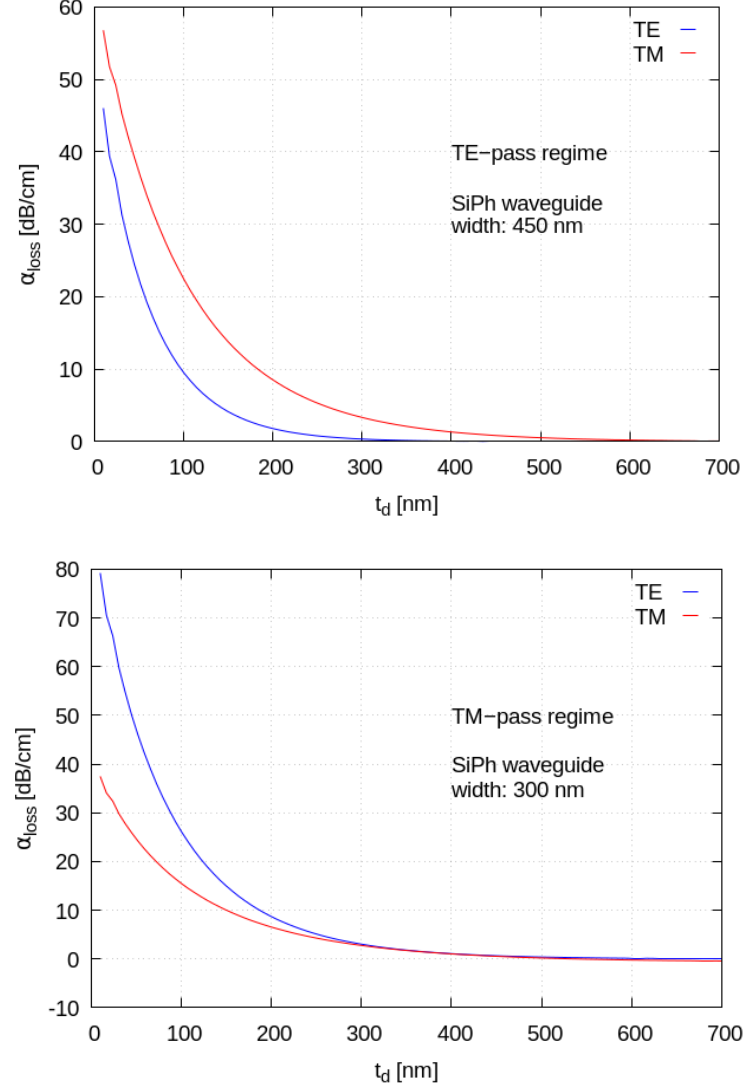
Figure 9. ( Top ): Mode absorption coefficients for a waveguide of width 450 nm. ( Bottom ): Mode absorption coefficients for a waveguide of width 300 nm. The absorption has been calculated as a function of the spacer thickness.